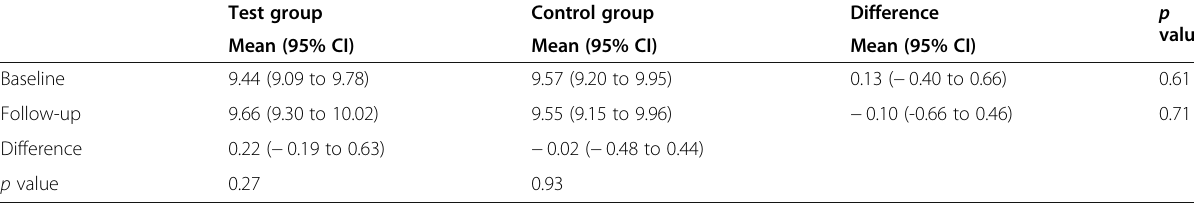
Table 4 Patient-related outcome measures at baseline and at the final follow-up